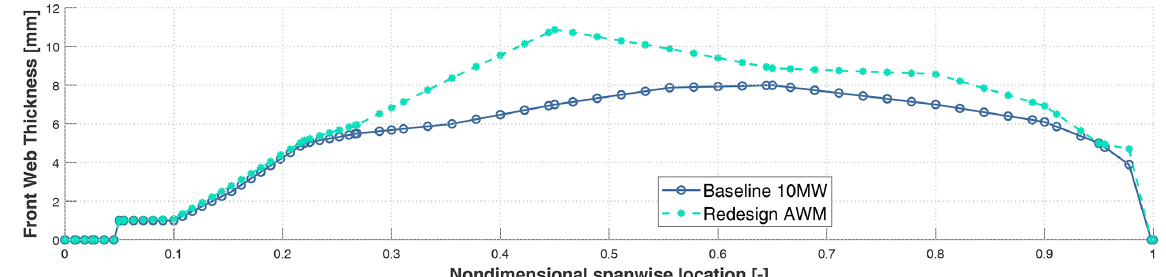
Figure 11. Redesign process including PCM: thickness distribution of the shear